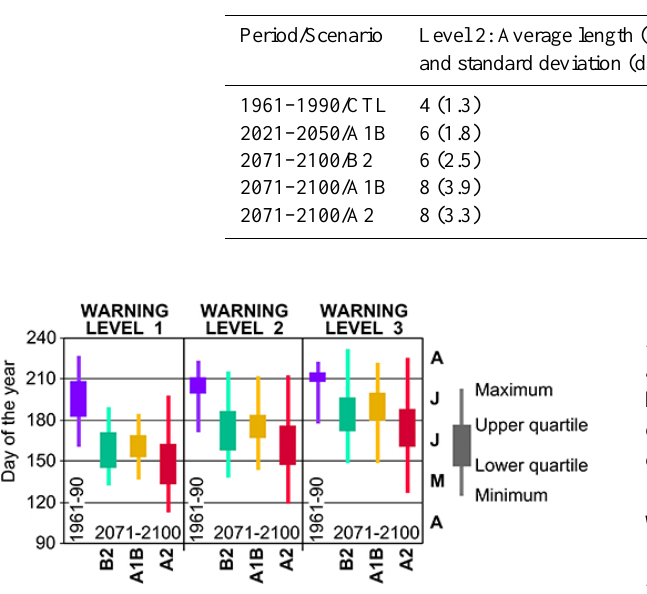
Fig. 5. Simulated first occurrences of heat wave warning levels for 1961–1990 and for 2071–2100 according to three different emis- sions scenarios. A, M, J, J, and A on the right indicate April, May, June, July, and August, respectively.